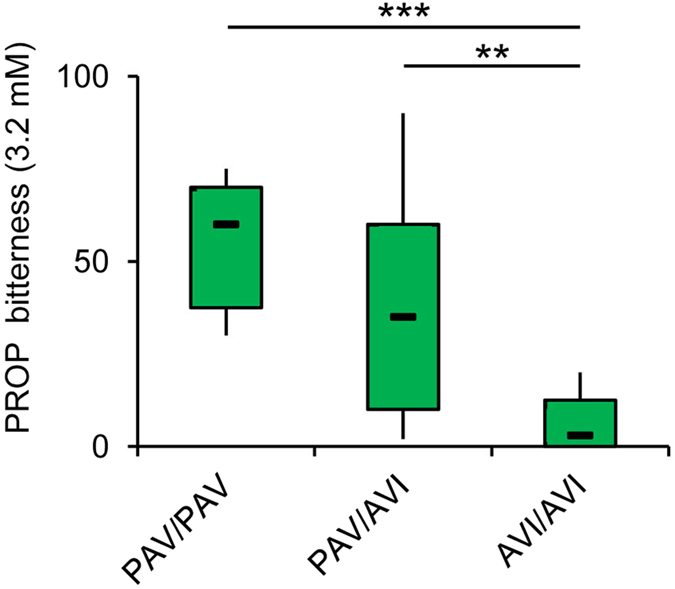
PROP bitterness intensity ratings (3.2 mM) according to TAS2R38 polymorphisms.One-way ANOVA: F2,40 = 11.294; P = 0.00014. The box-and-whisker plots show the minimum, first quartile, median, third quartile, and maximum of each set of data. n = 7 individuals with genotypes PAV/PAV in TAS2R38 locus, n = 25 PAV/AVI genotypes and n = 11 AVI/AVI genotypes. ***P < 0.001 determined by the Newman-Keuls post hoc test.